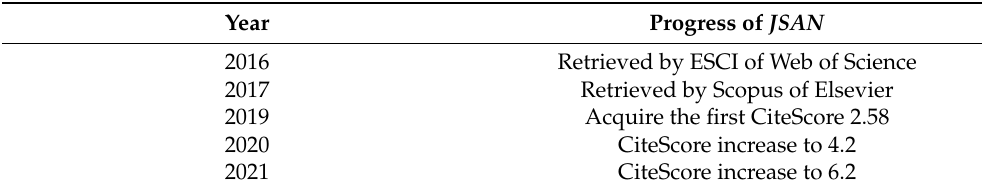
Table 2. The steady development of JSAN has been recognized by some international journal evaluation institutions